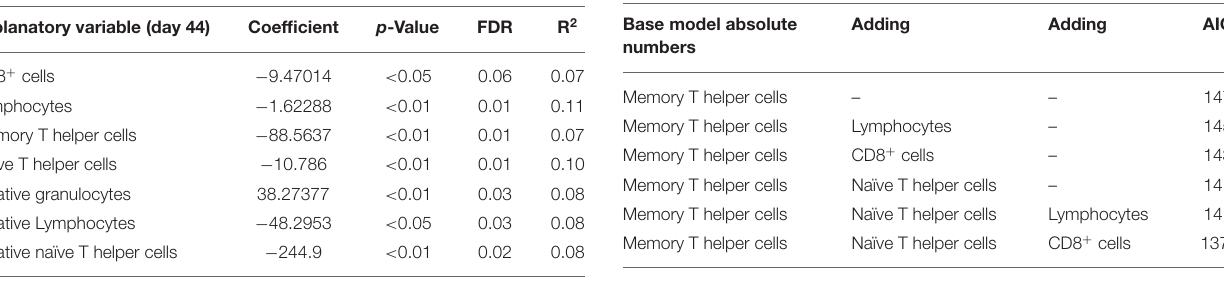
TABLE 6 | Multivariable approach results with absolute numbers of different white blood cells.